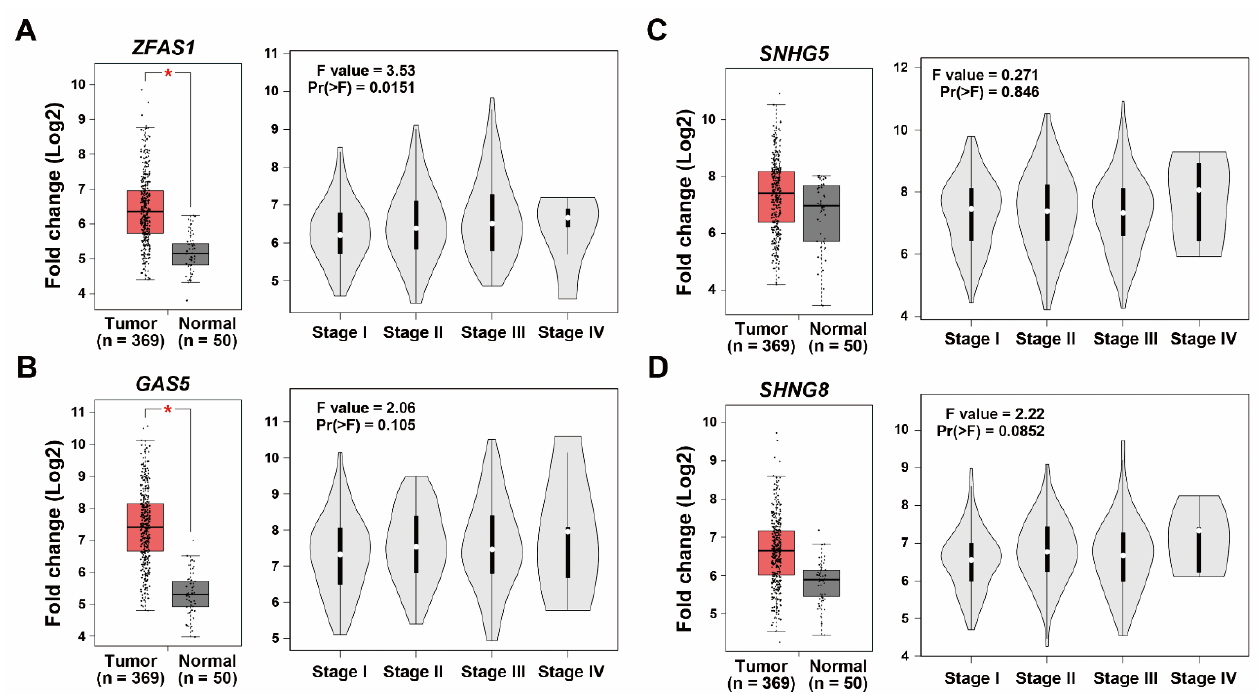
Figure 2. The expression of lncRNAs in HCC. The expressions of ZFAS1 ( A ), GAS5 ( B ), SNHG5 ( C ), and SNHG8 ( D ) in normal and cancer tissues (left part), and during tumor stage (right part) in HCC patients were obtained from the GEPIA database. * p < 0.05 indicated the statistically significant difference compared to the normal group.